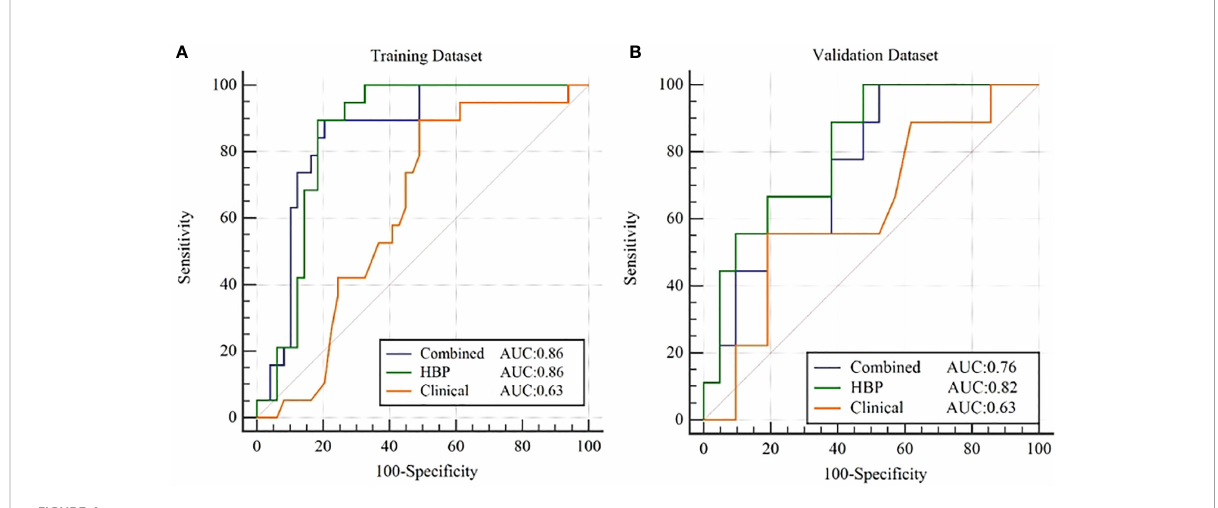
FIGURE 4 ROC curves for b -catenin mutation prediction of the clinical model, R HBP radiomics model and combined model in the training (A) and validation (B) dataset.